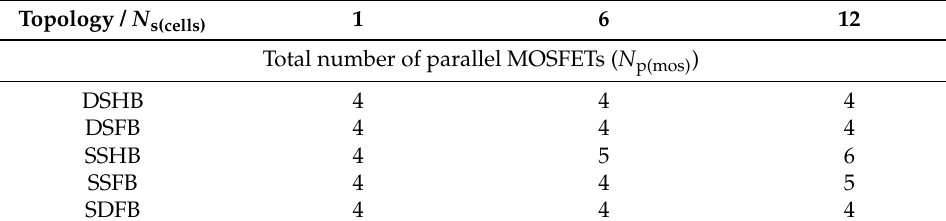
Table A1. The total number of parallel MOSFETs per switch, maximum MOSFET on-state resistance, MOSFET switching frequency during traction, and SM case-to-ambient thermal resistance for all topologies with 1, 6, and 12 N s(cells)